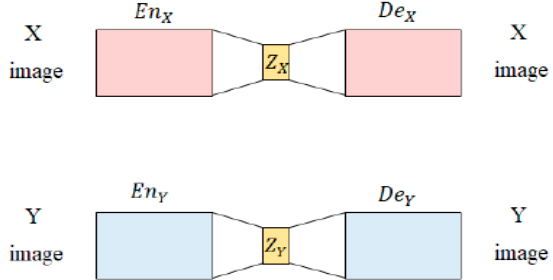
Figure 2. The architecture of an auto-encoder for pre-training the latent space of domain X and the latent space of domain Y.